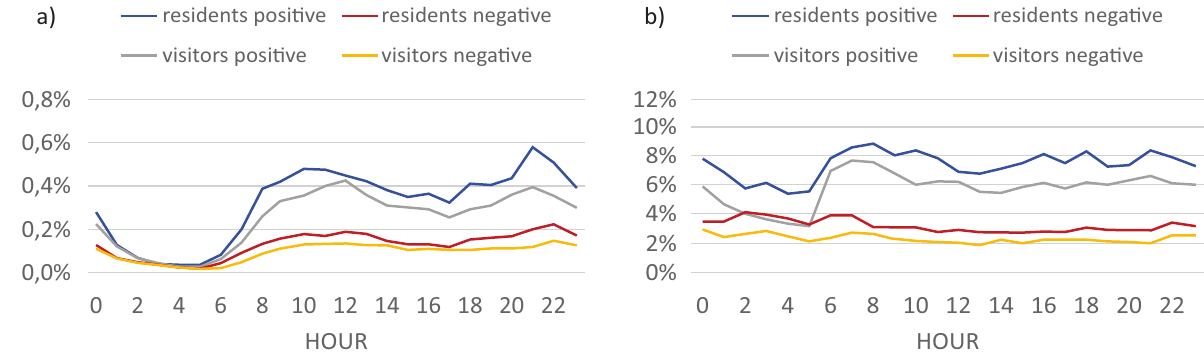
Figure 12. Positive and negative tweets per hour (%): a) as absolute values–every hour compared to the number of all tweets during the OG for residents and for visitors; b) as relative values–every hour compared to the number of all tweets in that hour during the OG for residents and for